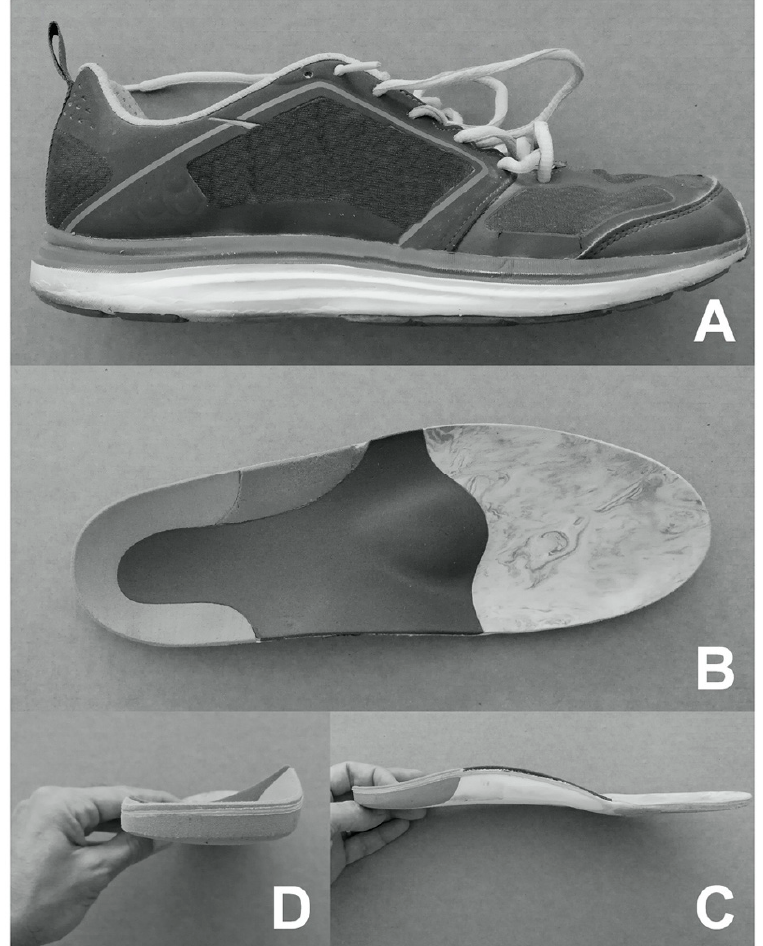
Figure 1. Shoes and insoles. ( A ) Lateral view of experimental shoe. The insoles were produced with an anatomical and ergonomic shape. Insoles had three-density Ethylene-Vinyl Acetate (EVA) full length, stabilization of the rear foot, support of the mid foot, and cushioning of the fore foot ( B ), physiological medial heel wedge ( C ), and physiological arch support ( D